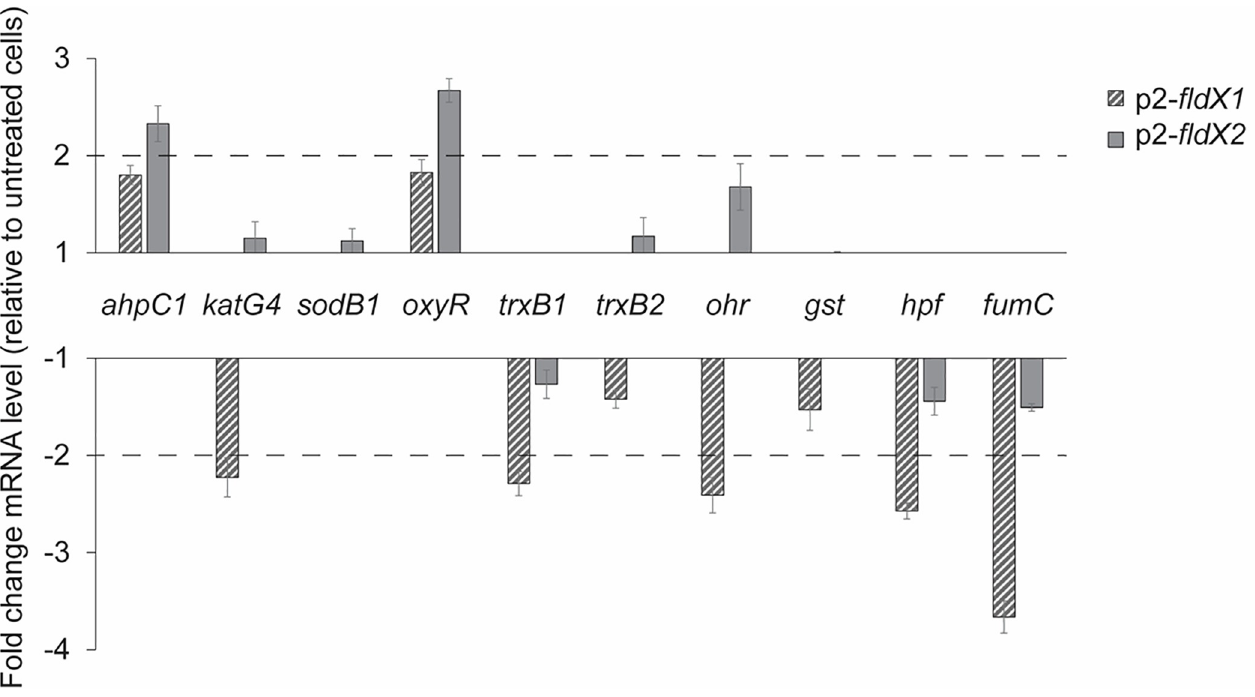
Fig 7. Transcriptional analysis of oxidative stress genes in P . xenovorans recombinant strains after exposure to paraquat. Cells at exponential phase were exposed to 1 mM paraquat during 1 h. The ftsZ and gyrB genes were used as reference genes. Significant differences were determined with a Tukey Test (p < 0.05) as indicated. Each value is an average ± SD of at least three independent experiments.